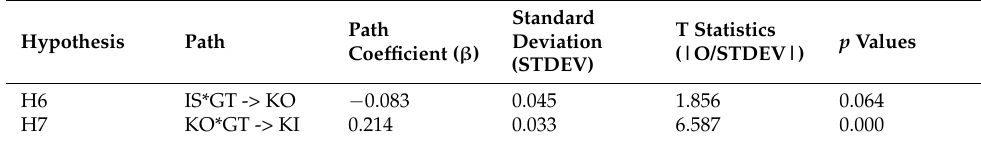
Table 9. Summary of moderating effect Table 8. Summary of mediating effects tests.